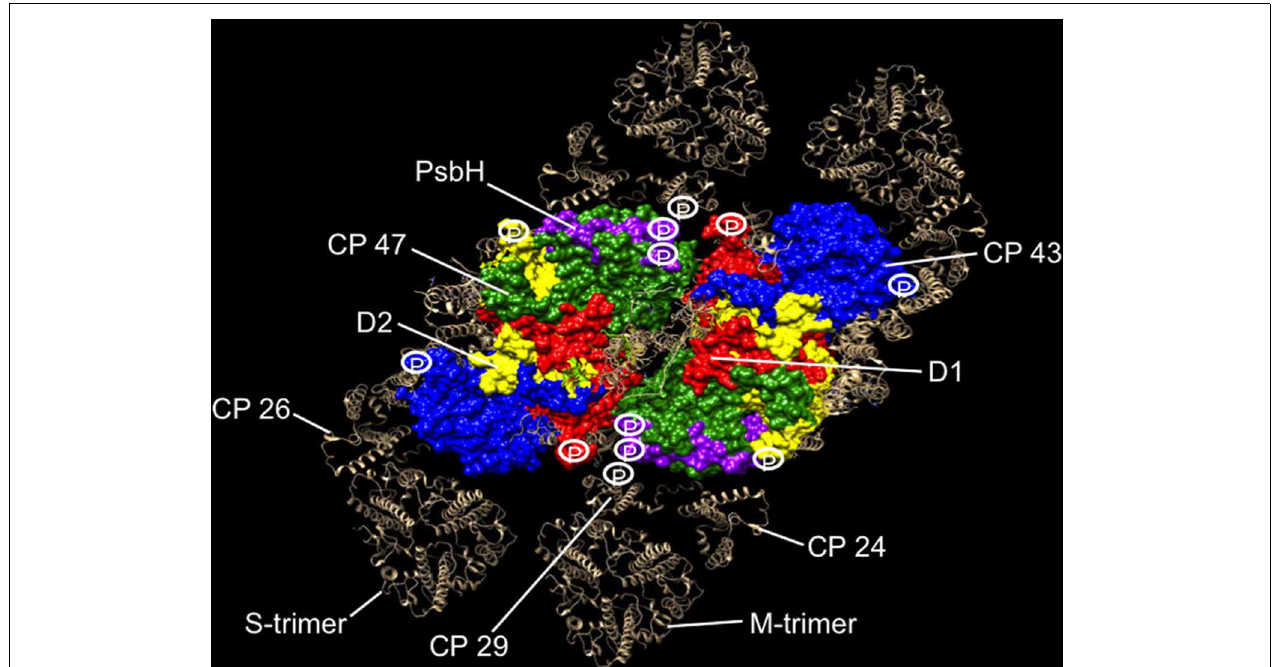
FIGURE 1 | Phosphorylation map of the C2S2M2 supercomplex as catalyzed by the Stn8 kinase. C2S2M2 rendered by the Chimera visualization program where the view is from the stromal side looking down. Coordinates for PS II core were taken from the pdb structure 3ARC (Umena et al., 2011), LHC II from 1RWT (Liu et al., 2004), and CP29 from 3PL9 (Pan et al., 2011). Since no structures were available for CP26 and CP24, CP29 coordinates were used instead. Supercomplex structure was modeled as in Caffarri et al. (2009). Major subunits of the core and the complete peripheral antenna are shown. Individual subunits of the core